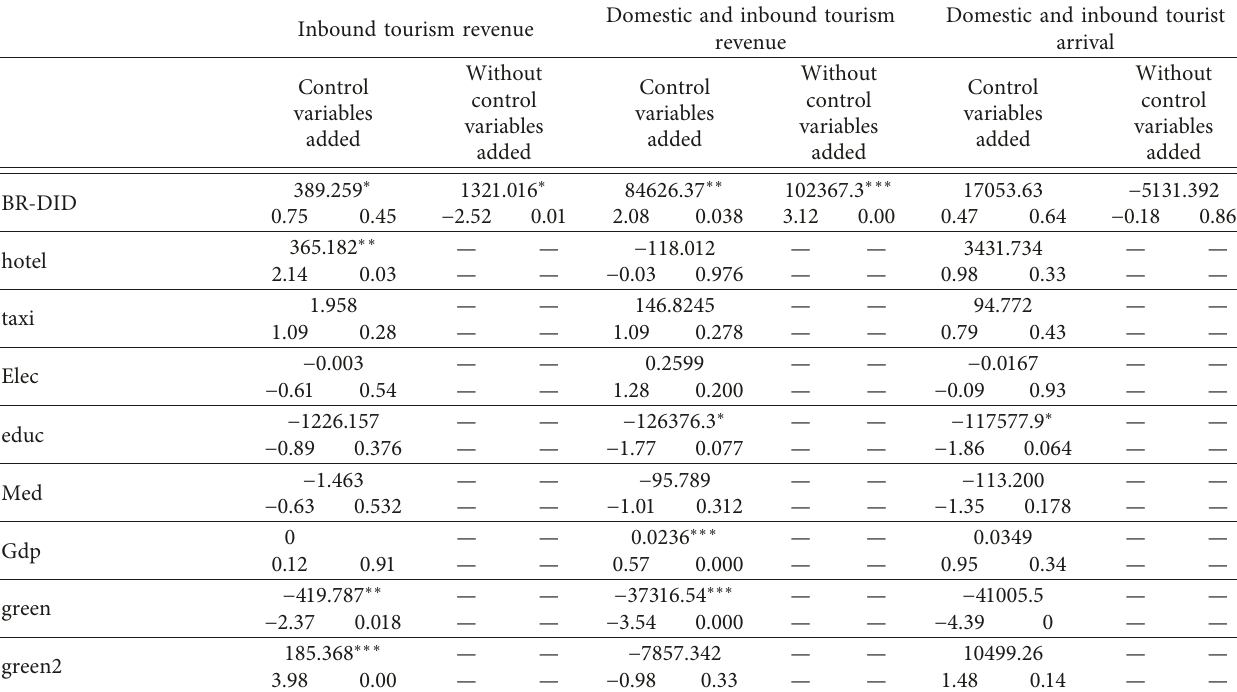
Table 3: Impact of “one belt, one road” on the tourism economy of the regions along the route (b). Inbound tourism